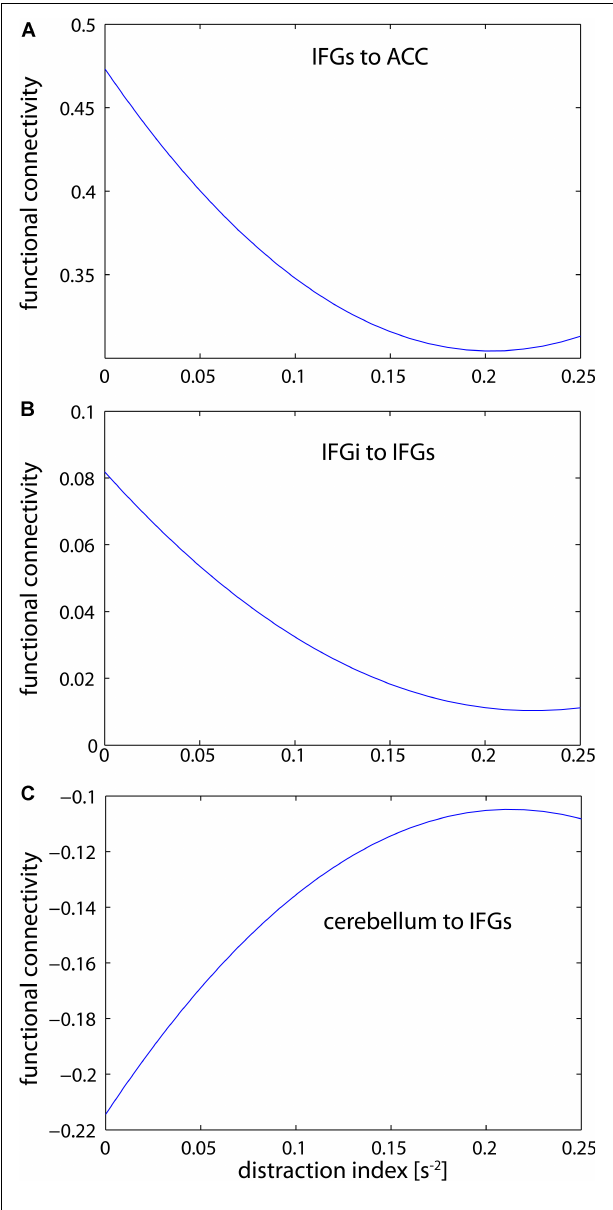
FIGURE 5 | Estimations of the distraction-connectivity function. Inter-frontal connectivity falls off but levels out with increasing distraction (A,B) . In contrast, cerebellar-frontal connectivity increases but also reaches a maximum level (C) . Interestingly, the connectivity estimate is negative in the latter path; thus the absolute correlation is also reduced with increasing distraction. (IFGs, superior parts of the inferior frontal gyrus; IFGi, inferior parts of the inferior frontal gyrus; CERE, cerebellum; ACC, anterior cingulate